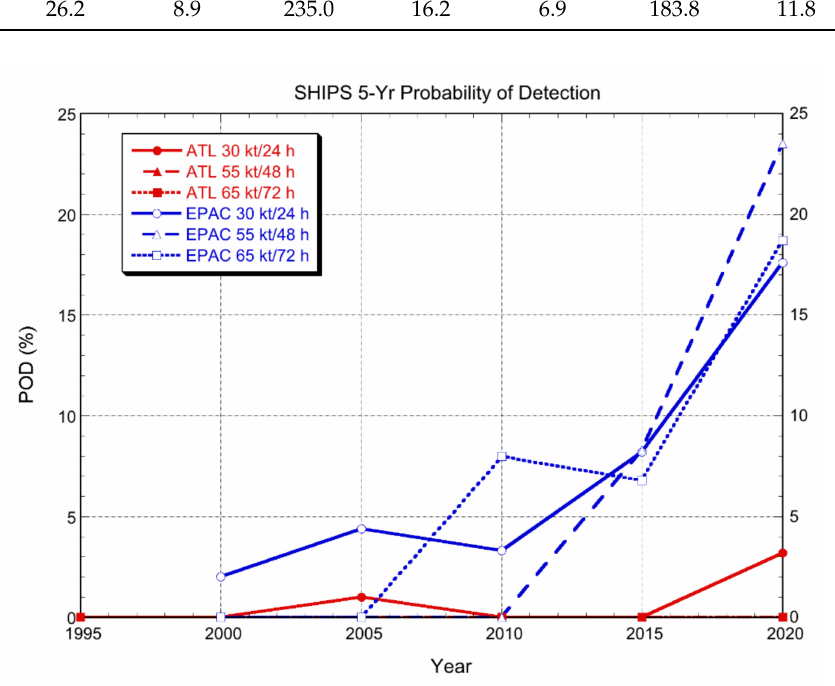
Figure 1. RI Probability of Detection (POD) for the SHIPS model from 1991–2000 for the Atlantic basin and from 1996–2020 for the eastern North Pacific basin for each of the three RI thresholds, 30 kt/24 h, 55 kt/48 h, and 65 kt/72 h. Each point on the diagram represents a five-year sample of forecasts ending at the year indicated (e.g., the 2016–2020 sample is shown at 2020). Figure 2 shows the Atlantic basin POD and FAR for the regional hurricane models. For the 30 kt/24 h threshold, the GFDL model had a POD of about 20%, which was a big improvement over SHIPS, which did not forecast RI at all during that period. However,